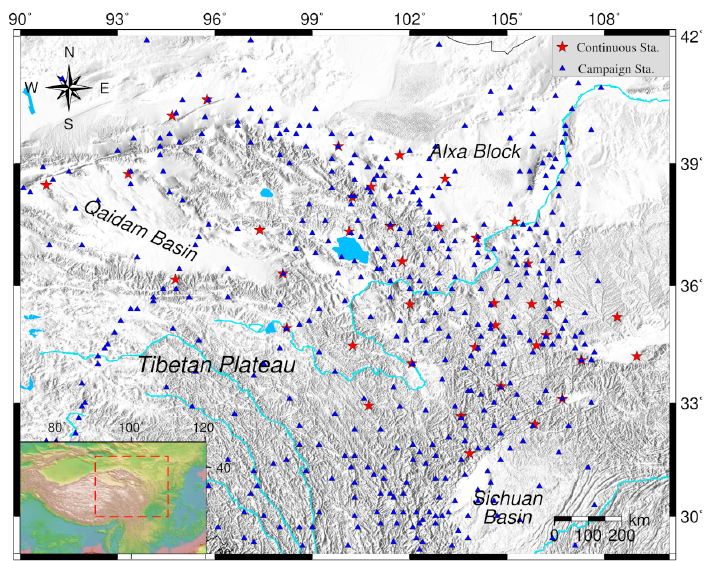
Figure 2. GPS site locations in northeastern Tibet, with 39 continuous stations and 451 campaign- mode stations. The red stars denote the continuous stations, and the green triangles denote the campaign-mode stations, with records spanning from March 2009 to January